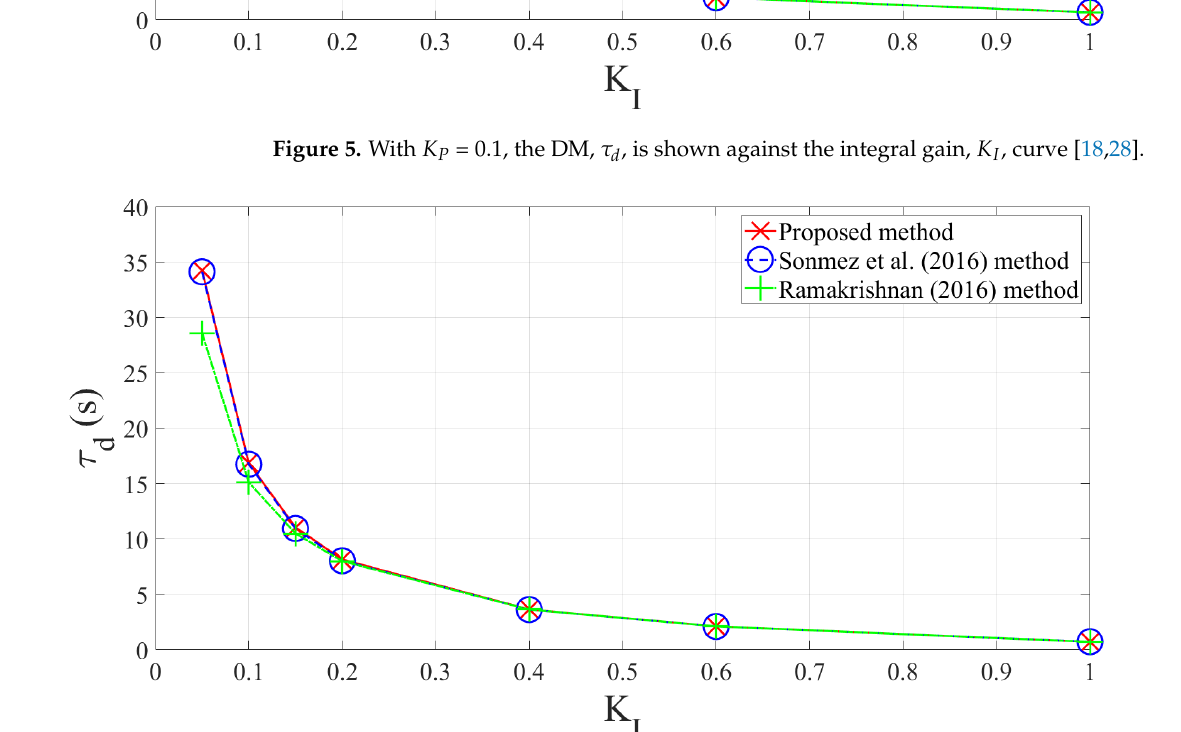
Figure 6. With K P = 0.2, the DM, τ d , is shown against the integral gain, K I , curve